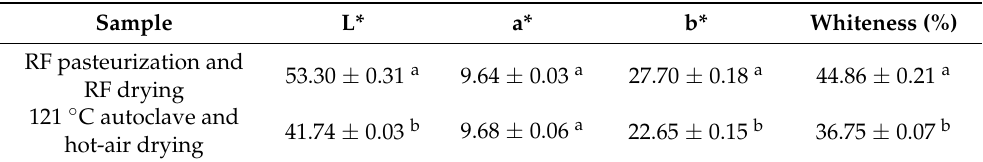
Table 2. Effect of different pasteurization and drying methods on the color of the solid-state fermented W. cocos product. Sample L* a* b* Whiteness (%) RF pasteurization and RF drying 121 ◦ C autoclave and hot-air